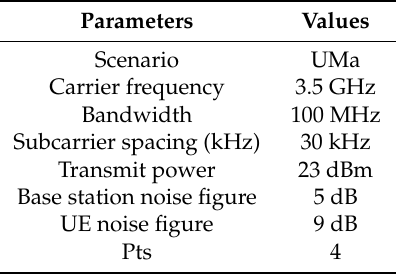
Figure 10. The spectral function of NC-MUSIC algorithm in TR38.901 channel model. Table 9. The parameters of the simulation system.